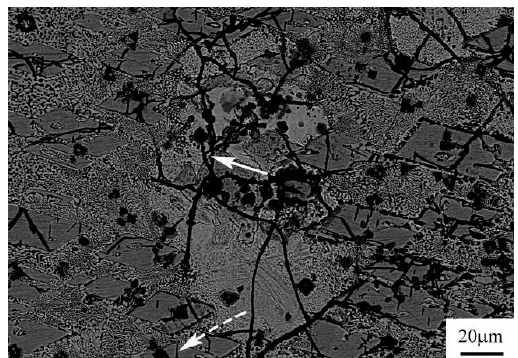
Figure 6. Microcracks in the hardfacing layer with 6.85% B addition.